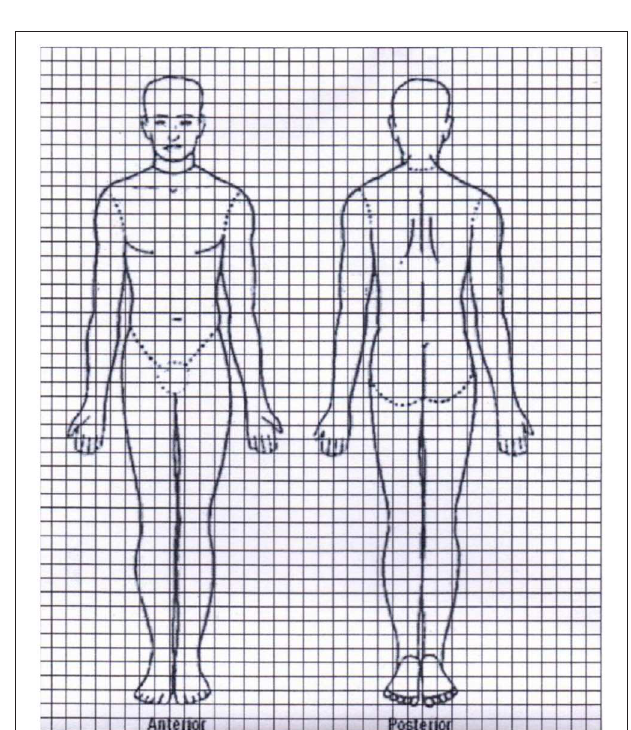
FIGURE 4 | PKDL lesions are plotted on a manikin, and the number of affected squares is recorded (Mondal et al., 2016).